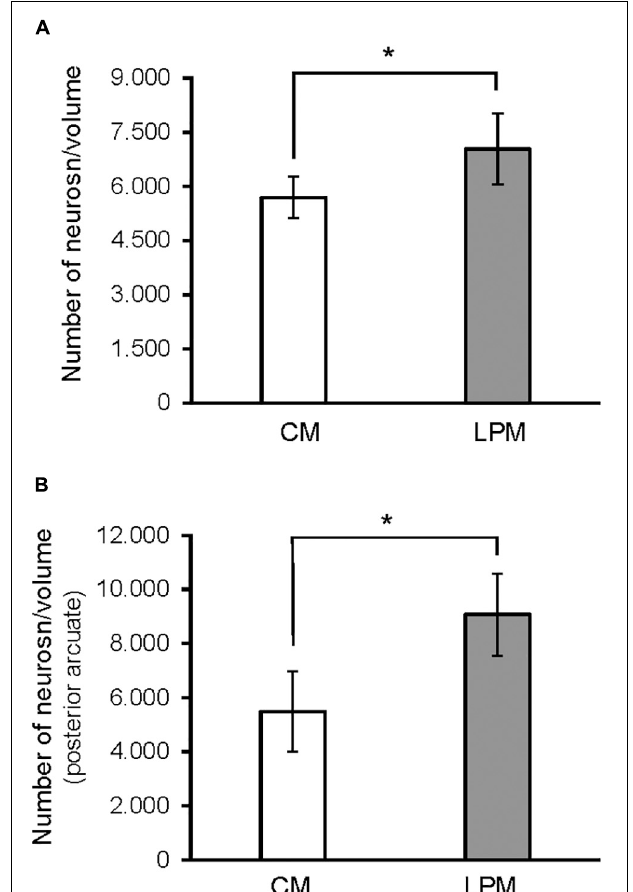
FIGURE 7 | Graph shows the differences in neuron density (calculated as number of neurons/volume) in (A) ARC nucleus (B) posterior ARC subdivision in males. CM, control male; LPCM, low-protein and low caloric male. *, significant differences between groups ( p < 0.05 in all cases). All values are expressed as means ±